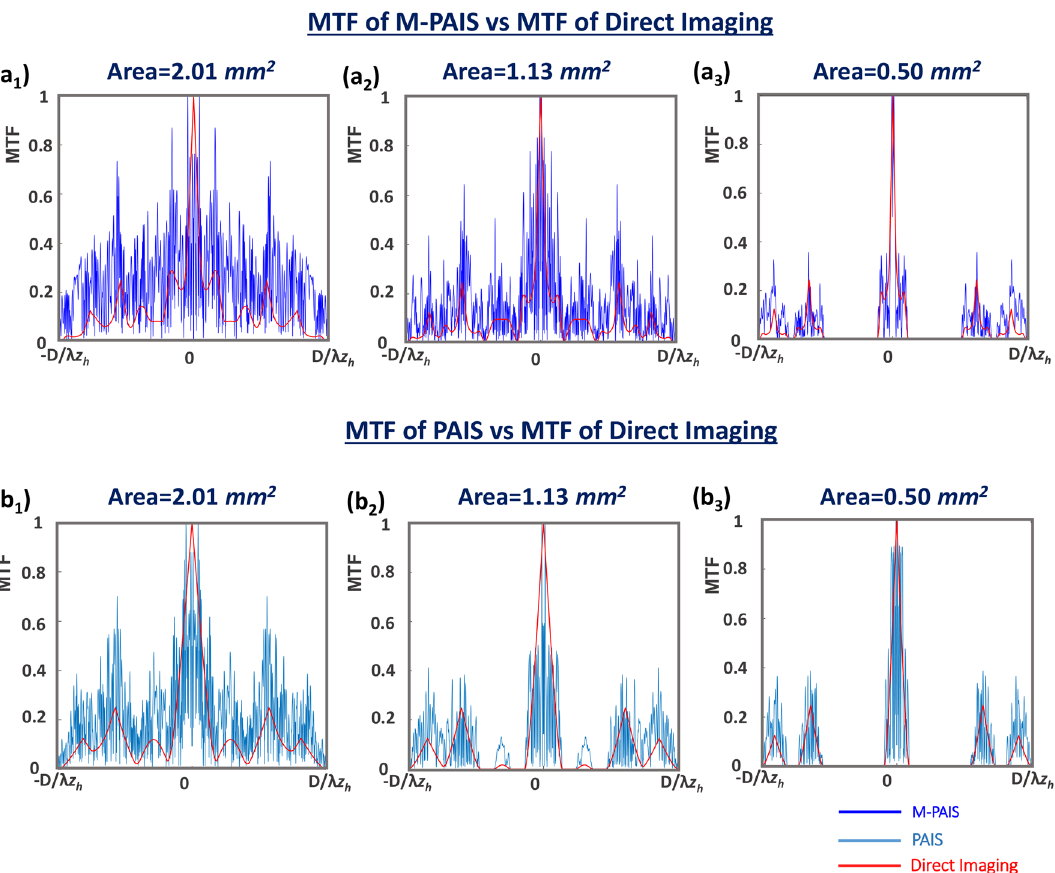
Figure 9. MTF cross-section plots for ( a 1 –a 3 ) M-PAIS and ( b 1 –b 3 ) PAIS in comparison to direct imaging for subaperture area of 2.01, 1.13 and 0.50 mm 2